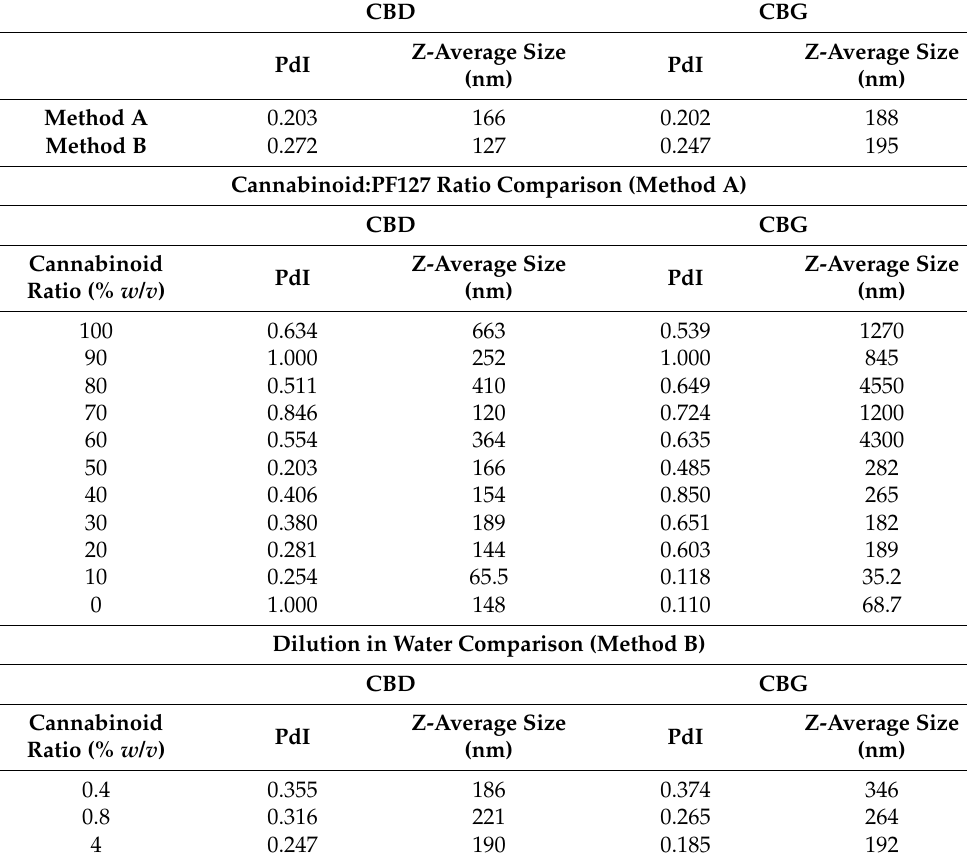
Table 2. Size and PDI values of different cannabinoid suspension formulations. Preparation Method (Cannabinoid:PF127